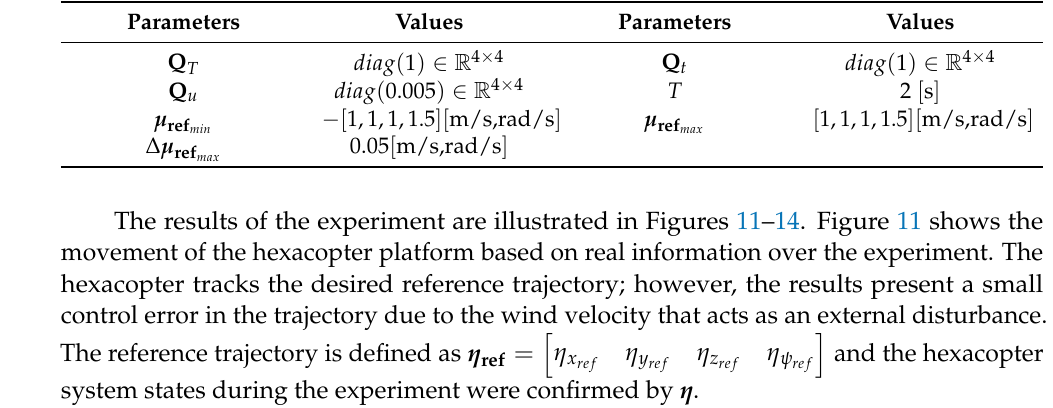
Table 5. Proposed values for the NMPC scheme in a real-world experiment.